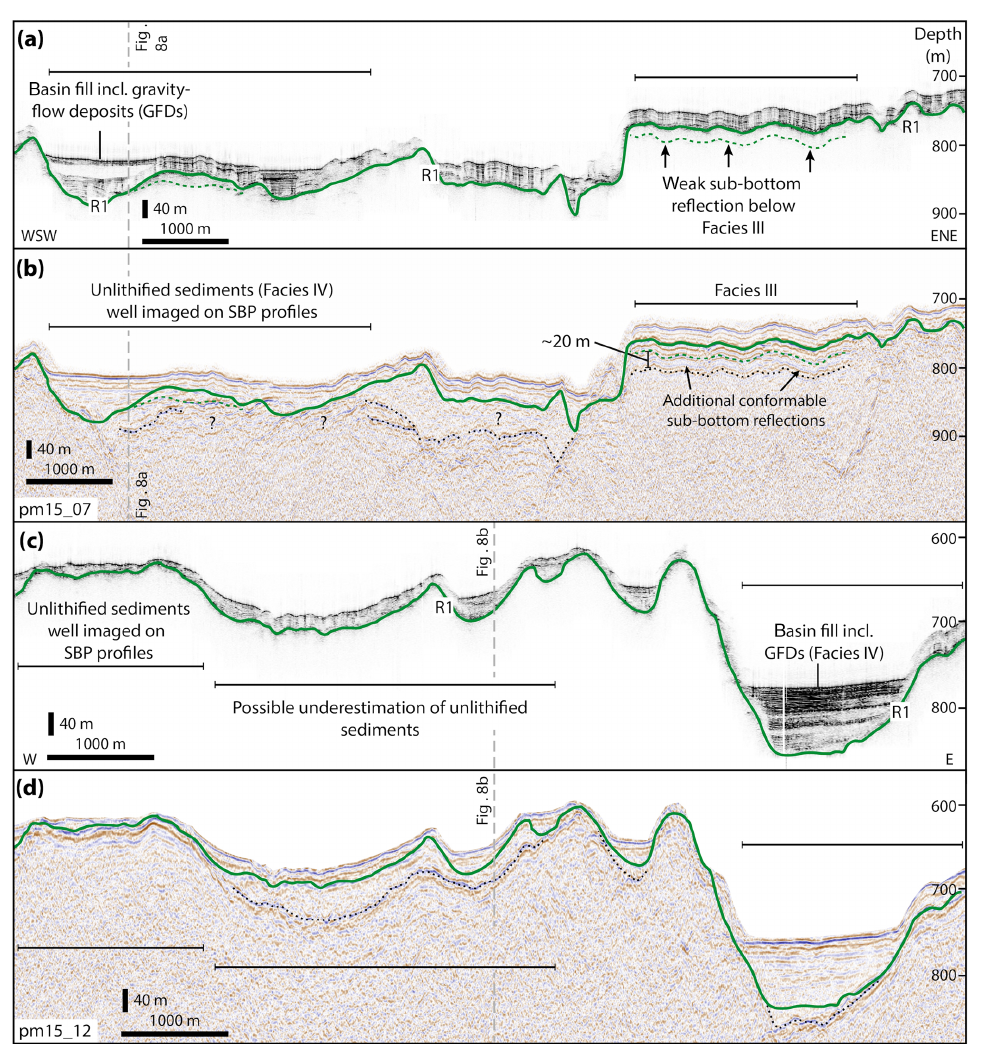
Figure 3. Comparison of SBP profiles with coincident AG profiles showing the mapped basal reflector (R1) on SBP profiles and the cor- responding reflector (green) on AG profiles. Dotted lines mark the lowermost reflections on each profile; dotted lines and question marks indicate the uncertainty in mapping of the unlithified sediment package over basement. Sub-bottom reflections may be geological boundaries in sedimentary bedrock in Hall Basin. (a) SBP profile acquired on 11 August 2015 in Hall Basin, coincident with AG profile pm15_07 (b) . (c) SBP profile from 18 August 2015 also in Hall Basin, coincident with AG profile pm15_12 (d) . The location of profiles is shown in Fig. 2; the intersection of Fig. 6b with panels (c) and (d) is shown as vertical grey dashed line.